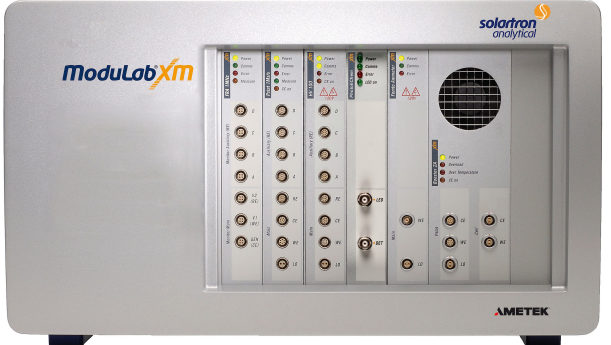
Figure 4. ModuLab Xm measuring device, by Solartron